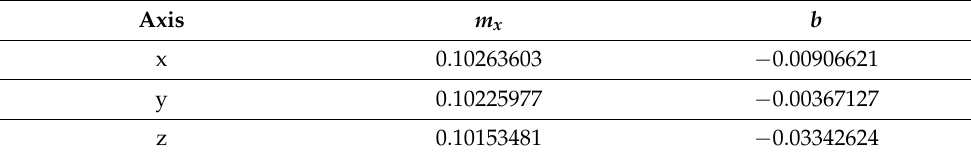
Figure 2. Connection of electronic devices to the Raspberry Pi 4B. Table 2. Calibration of